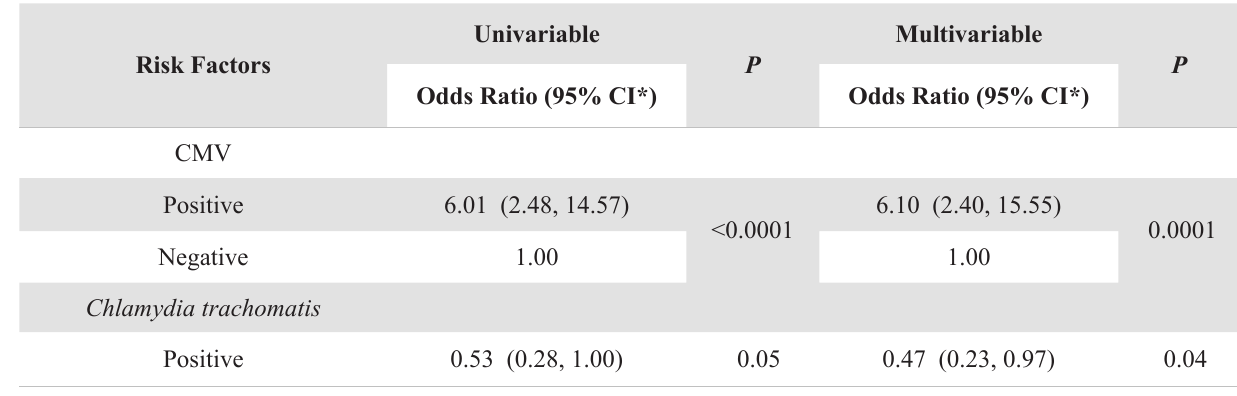
Table 2 . Associations with Uterine Leiomyoma (N=92 Cases, 94 Controls)